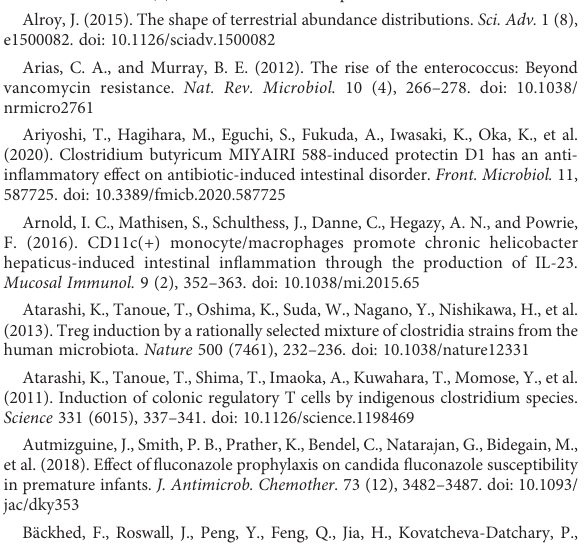
SUPPLEMENTARY FIGURE 1 Evaluation of microbiome composition in newborns. Three indexes of alpha diversityaredisplayed: (A) theChao1index, (B) theShannonindex,and (C) the Simpson index. The results are shown as mean ± SEM. There were no